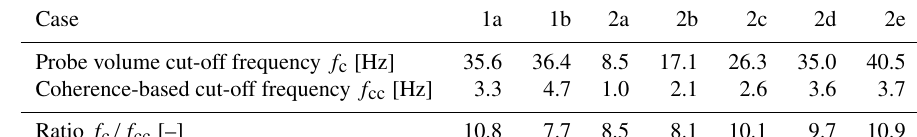
Table 5. Estimated probe volume and coherence-based cut-off frequencies, f c and f cc respectively, of the spectrum of WindScanner 2 with respect to the hot wire.